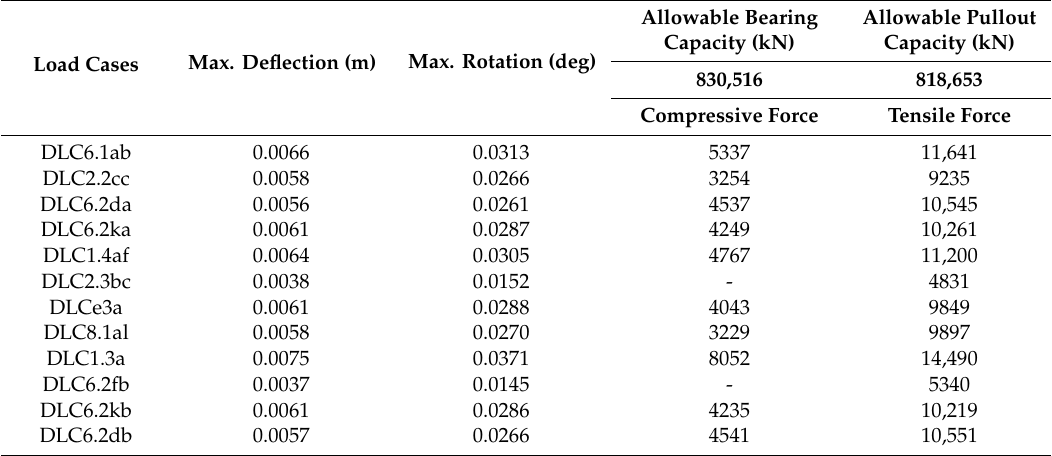
Table 8. Maximum deflections, rotations, allowable capacities, and loads of the piles.